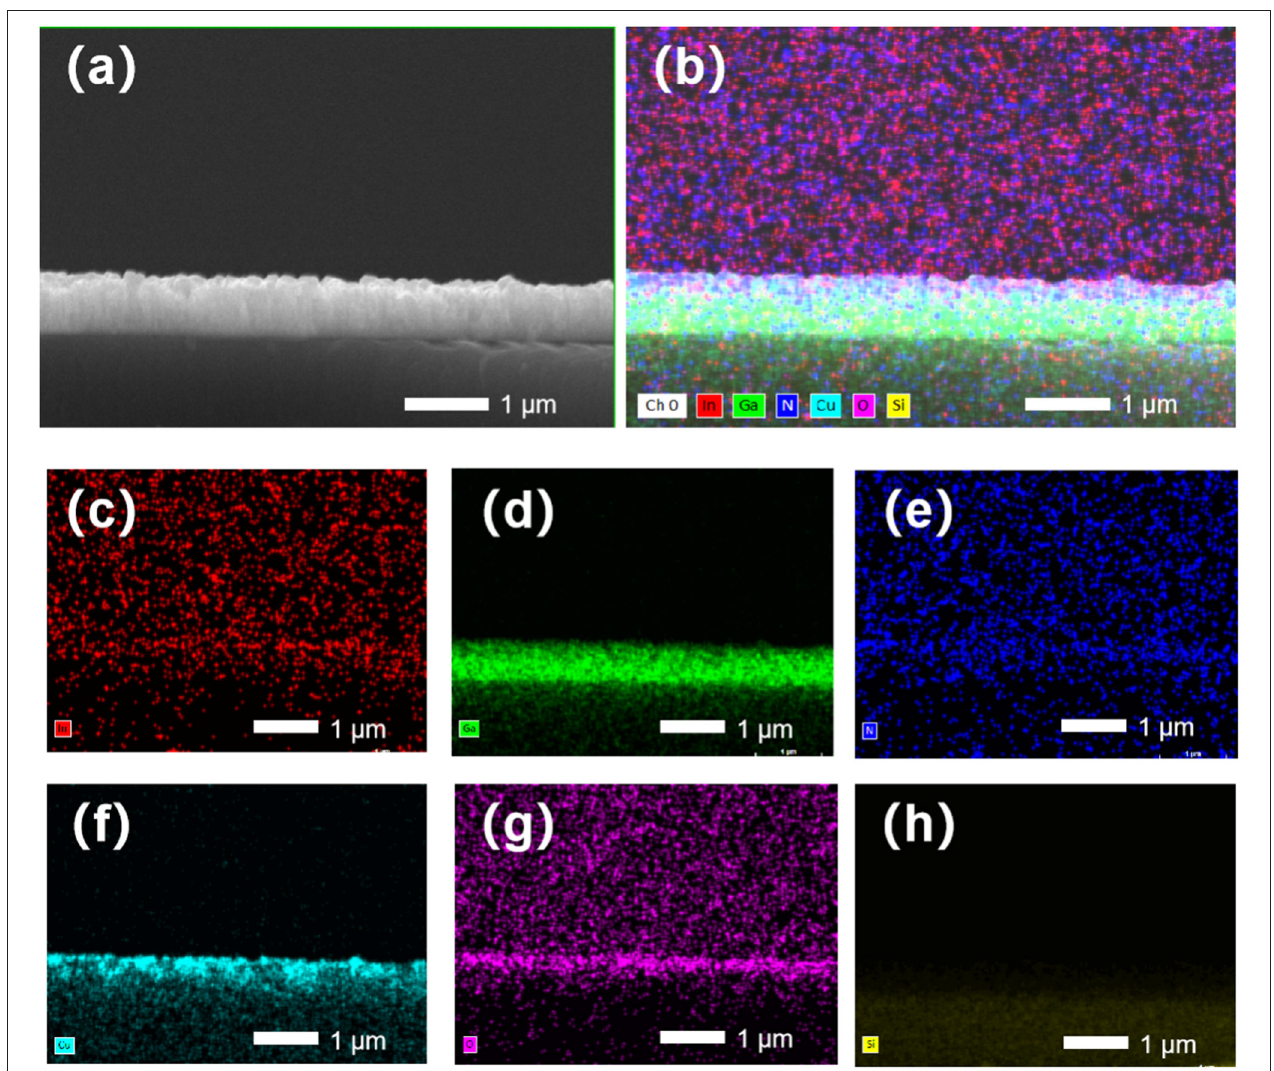
FIGURE 2 | (a) Cross-sectional SEM image and (b–h) energy dispersive X-ray spectroscopy (EDS) element mappings. (b) Total EDS intensity and (c–h) In, Ga, N, Cu, O, and Si element mappings.